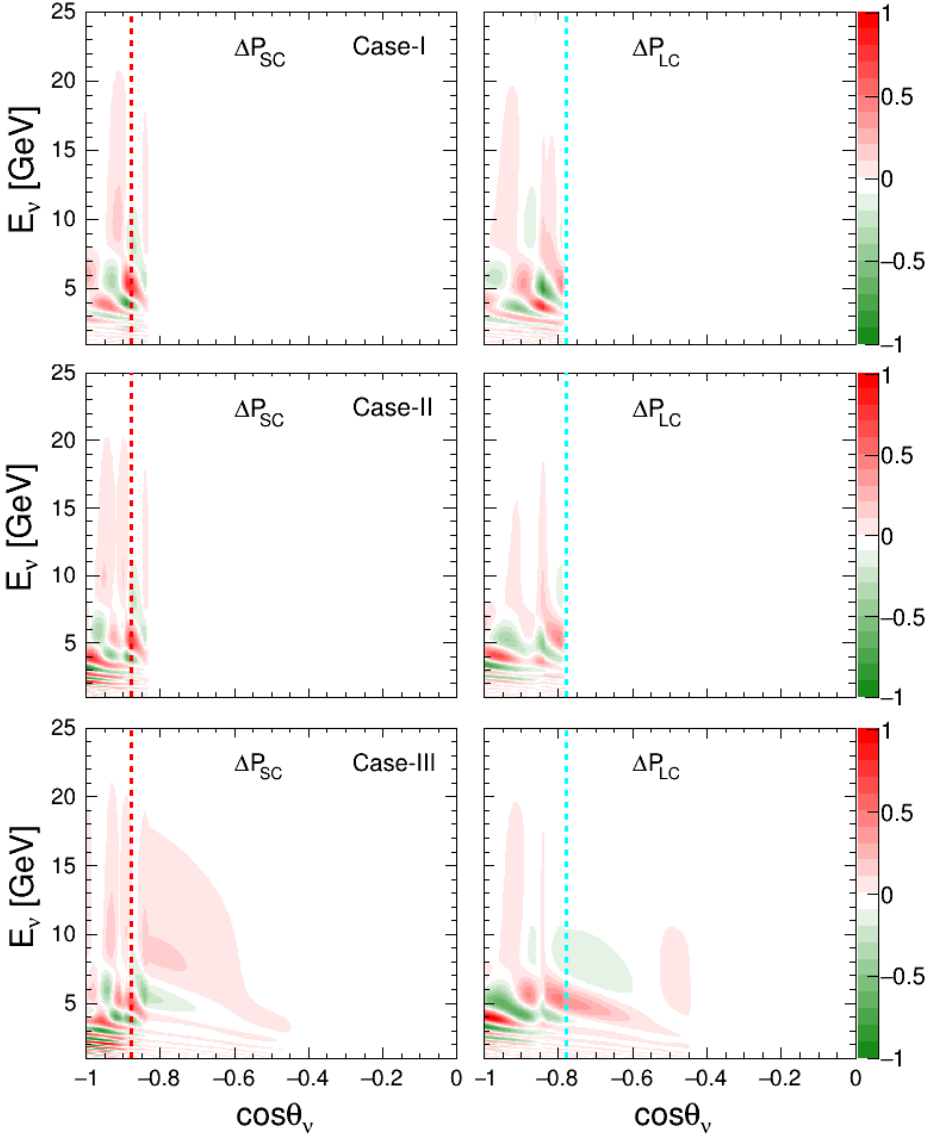
Figure 6 . Three-flavor ν µ → ν µ survival probability difference oscillograms for the three-layered profile of Earth. Here, ∆ P ( ∆ P ) in the left (right) panels denote P( ν SC LC bility difference between the standard core and SC (LC) scenario with ∆ R km). The dotted-red and dotted-cyan curves represent the CMB radius for the smaller core and larger core, respectively. Top, middle, and bottom rows correspond to the Case-I, Case-II, and Case-III, respectively. We use the three-flavor neutrino oscillation parameters given in table 2, where we assume NO and sin 2 θ = 23